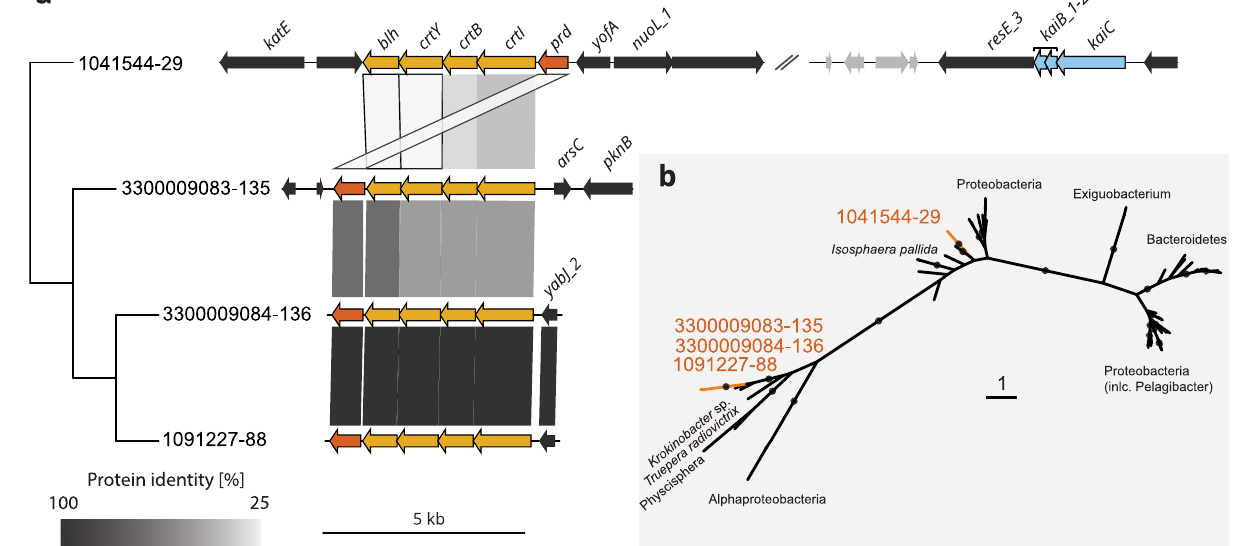
Fig. 4 Independent acquisition of light-driven ATP synthesis in two potentially amoeba-associated clades. a Gene synteny plot of proteorhodopsin related gene clusters in Parachlamydiaceae MAGs. Comparisons are ordered according to the phylogenomic species tree in Fig. 1. Arrows colored in orange, yellow, and blue represent proteorhodopsin ( prd ), carotene biosynthesis, and circadian clock genes, respectively. Black arrows indicate genes with chlamydial homologs. Bands connect homologs and are colored according to their protein identity. All other proteins of contigs encoding proteorhodopsin gene clusters were blasted against the NCBI non-redundant (nr) database to con fi rm the chlamydial origin of the contig. b Maximum likelihood phylogenetic tree of proteorhodopsin (Prd) (ENOG4105CSB) with chlamydial sequences showing two distinct clades. Maximum likelihood tree was inferred under LG + C30 + G + F model with 1000 improved ultrafast bootstraps and 1000 replicates of the SH-like approximate likelihood ratio test. Filled circles at nodes indicate a bootstrap support ≥ 95%. Scale bar indicates the number of substitutions per